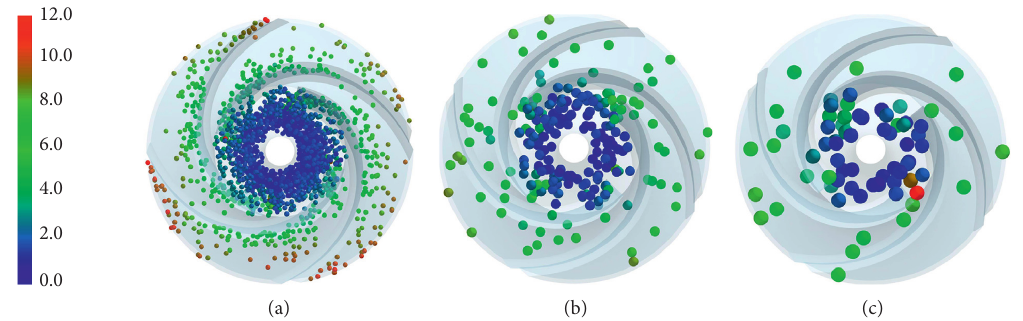
Figure 8: Particle distribution in impeller region: (a) 5mm, (b) 10mm, and (c)